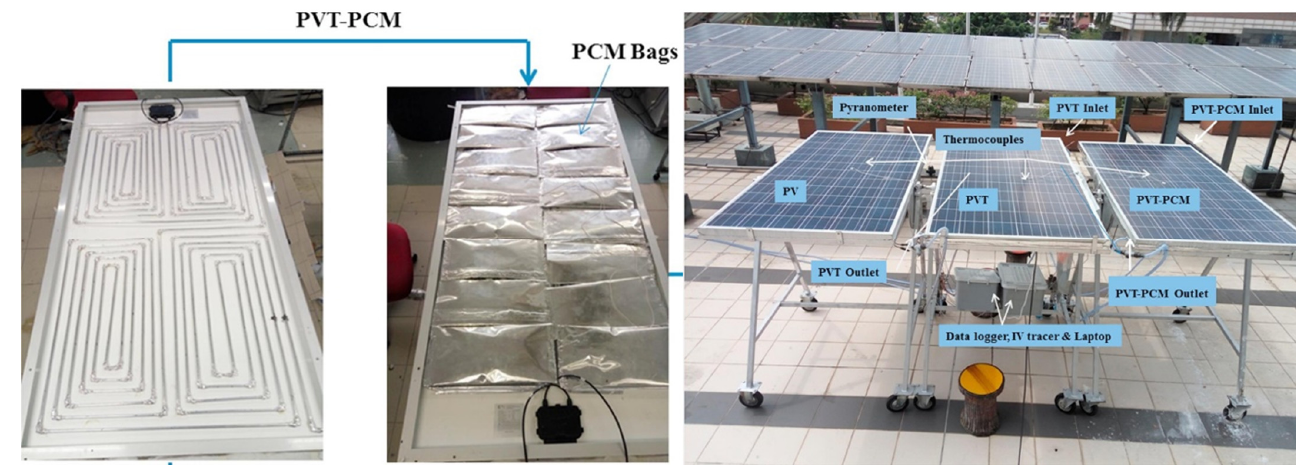
Figure 14. The fabrication process and outdoor experimental setup of PVT and PVT-PCM systems. Reprinted with permission from Ref. [119]. 2019. Fayaz et al.